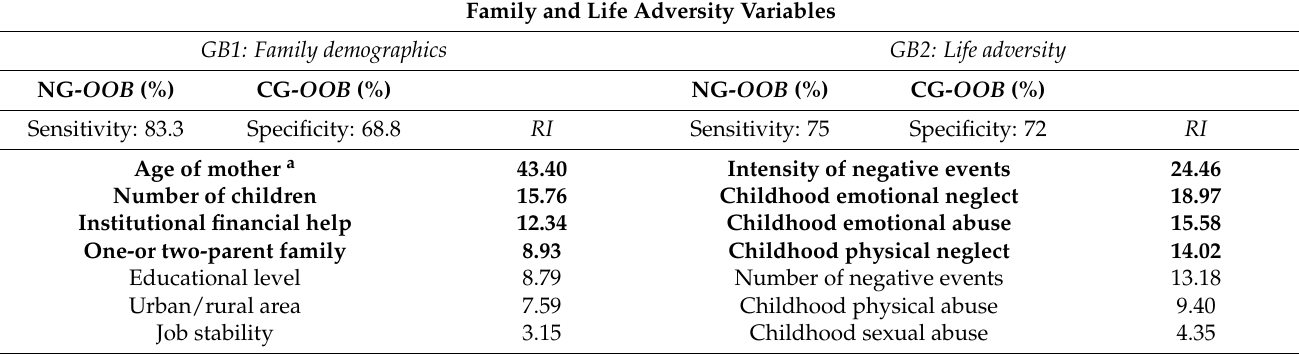
Table 2. Gradient boosting analyses estimated on the two sets of family and life adversity variables showing good “out of bag” ( OOB ) sensitivity and specificity, and the relative importance (RI) of the variables for the distinction of the neglected group (NG) and the non-neglected control group (CG).